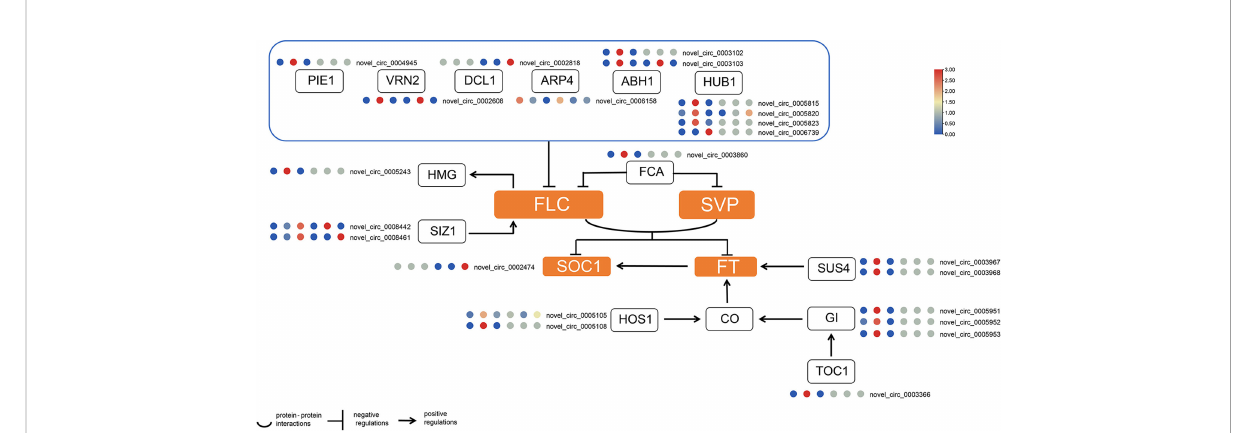
FIGURE 3 Transcript abundance of fl owering-related circRNAs in hickory buds. The circRNA expression level was presented in relative mean counts per million (CPM). The six plots from leftmost to the rightmost represent F1, F2, F3, M1, M2 and M3 respectively. The scale bar is the relative mean of CPM. The square denotes genes or proteins, while the orange represents integrator gens or proteins. PEI1 , PHOTOPERIOD-INDEPENDENT EARLY FLOWERING 1 ; HUB1 , HISTONE MONOUBIQUITINATION1 ; VRN2 , VERNALIZATION 2 ; DCL1 , DICER-LIKE 1 ; ABH1 , ABA HYPERSENSITIVE 1 ; ARP4 , ACTIN-RELATED PROTEIN 4; HMG , HIGH MOBILITY GROUP ; FCA , FLOWERING CONTROL LOCUS A ; SIZ1 , SALT INDUCED ZINC FINGER PROTEIN1 ; FLC , FLOWERING LOCUS C ; SVP , SHORT VEGETATIVE PHASE ; SOC1 , SUPPRESSOR OF OVEREXPRESSION OF CO 1 ; FT , FLOWERING LOCUST T ; SUS4 , SUCROSE SYNTHASE 4 ; HOS1 , HIGH EXPRESSION OF OSMOTICALLY RESPONSIVE GENES 1 ; CO , CONSTANS ; GI , GIGANTEA ; TOC1 , TIMING OF CAB EXPRESSION 1